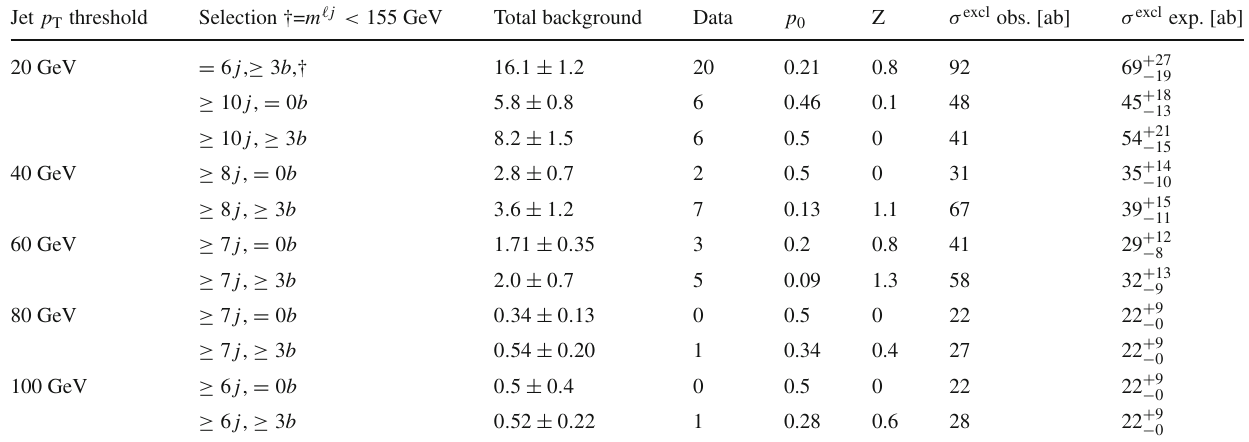
Table 7 Data event yields compared with the expected contributions from relevant background sources, in the discovery signal regions defined for the 2 (cid:3) sc category. The p 0 -value, and corresponding sig- nificance (Z), as well as the observed and expected 95% CL model- independent upper limits on the product of cross-section, acceptance